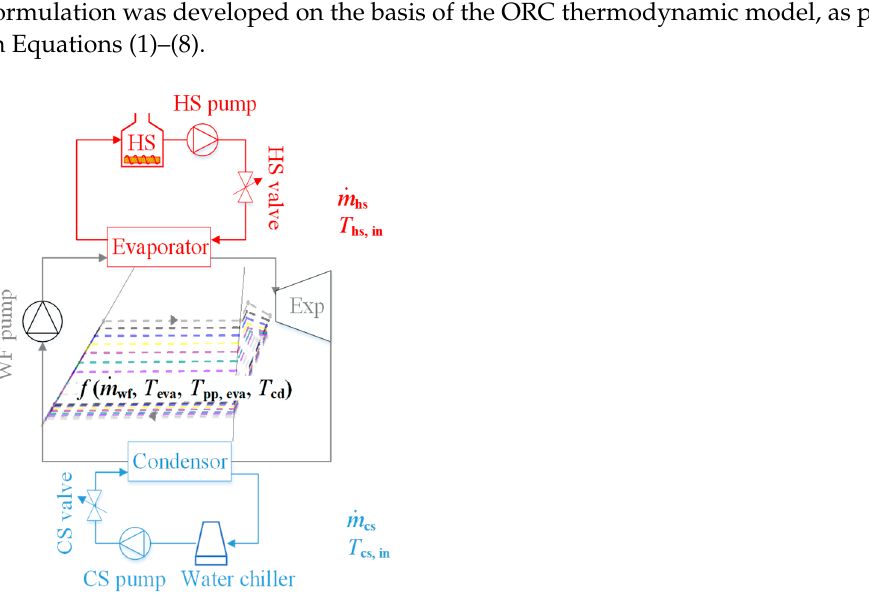
Figure 2. Schematic of a practical ORC system with operation parameters.